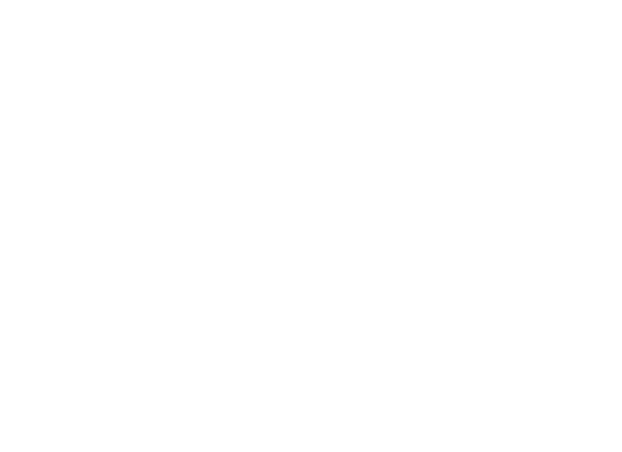
Figure 3. Residual Unit of residual network. It is the smallest unit in the primitive face feature extraction